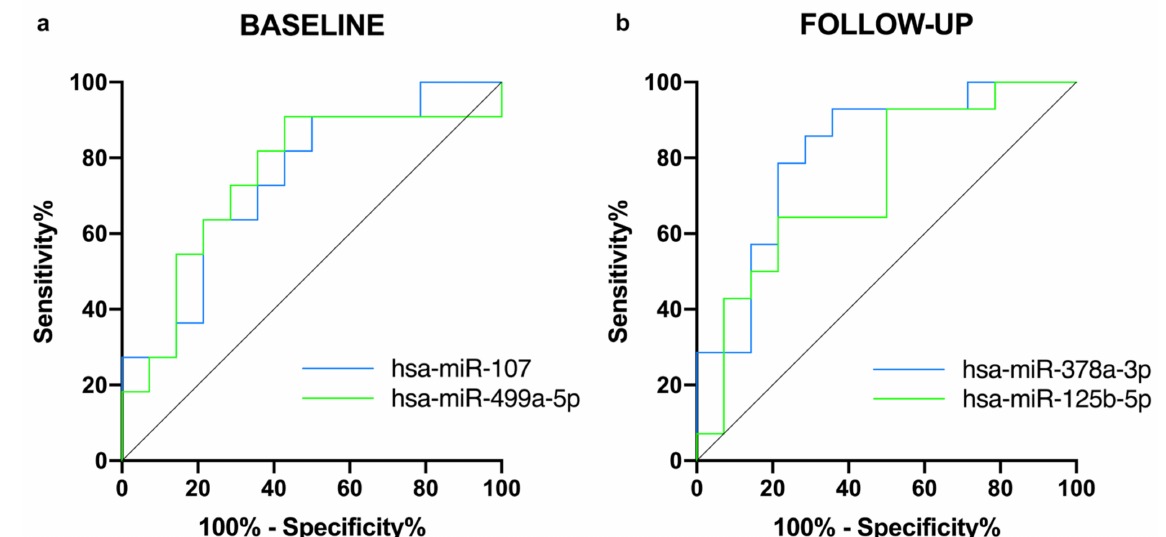
Figure 4. Predictive capacity of CRT success. Receiver-operating characteristic (ROC) curves compar- ing sensitivity and specificity of ( a ) baseline and ( b ) follow-up differentially expressed miRNAs in predicting CRT response.